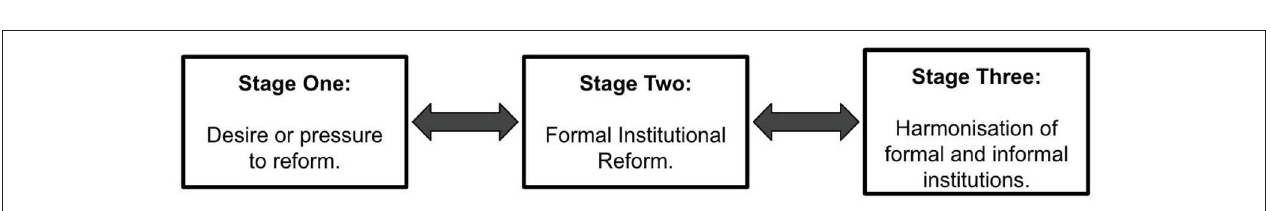
FIGURE 2 | Van de Mortel model of three transition